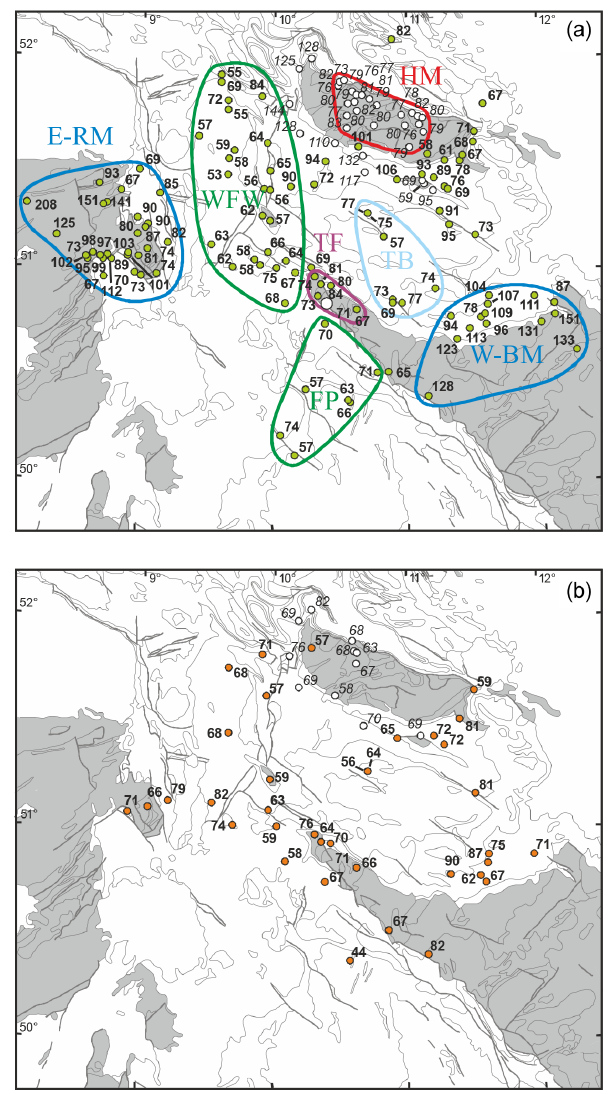
Figure 7. Spatial presentation of the new apatite fission- track (a) and (U–Th) / He ages (b) . The map is a simplified version of Fig. 3; grey represents Permian Rotliegend and older formations (i.e. pre-Zechstein). Coloured envelopes in (a) highlight the regions defined in the text and Fig. 3, where most of the samples are clus- tering. Small white circles in and around the Harz Mountains in- dicate localities of low- T thermochronology data by von Eynatten et al. (2019). The bigger white circle in the Thuringian Forest in- dicates the locality of the AFT samples from the Ruhla Crystalline Complex; Thomson and Zeh (2000).